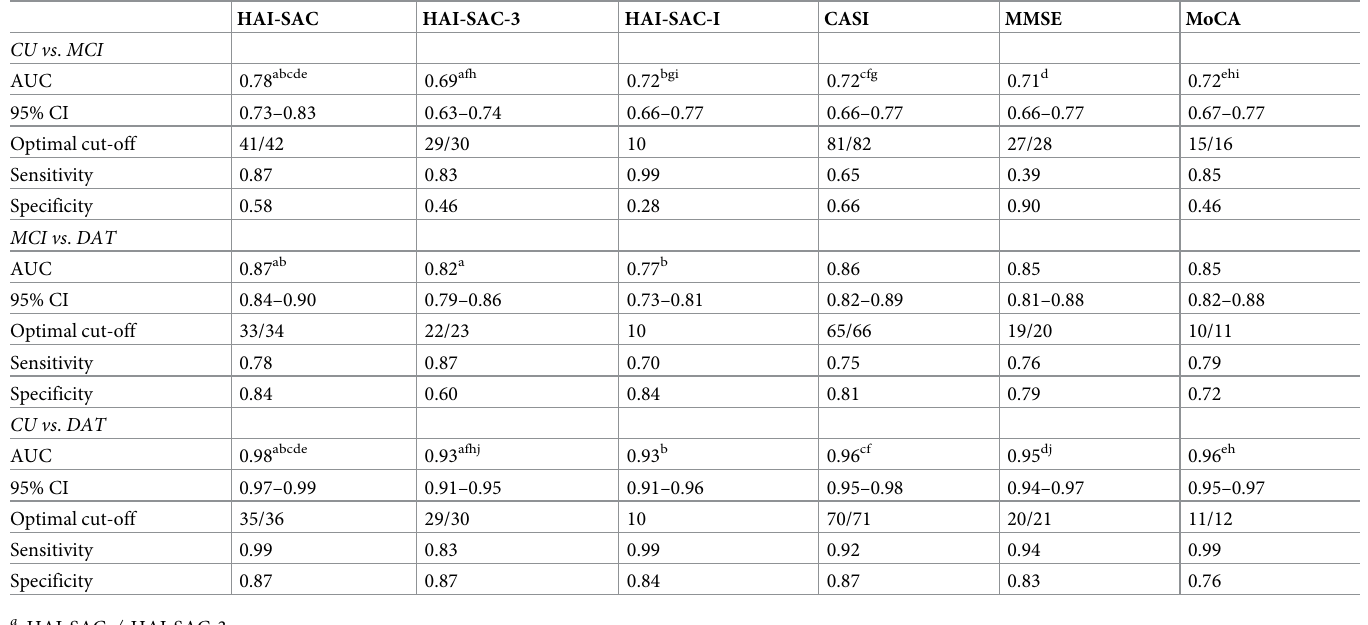
Table 4. AUC and cut-off points of the